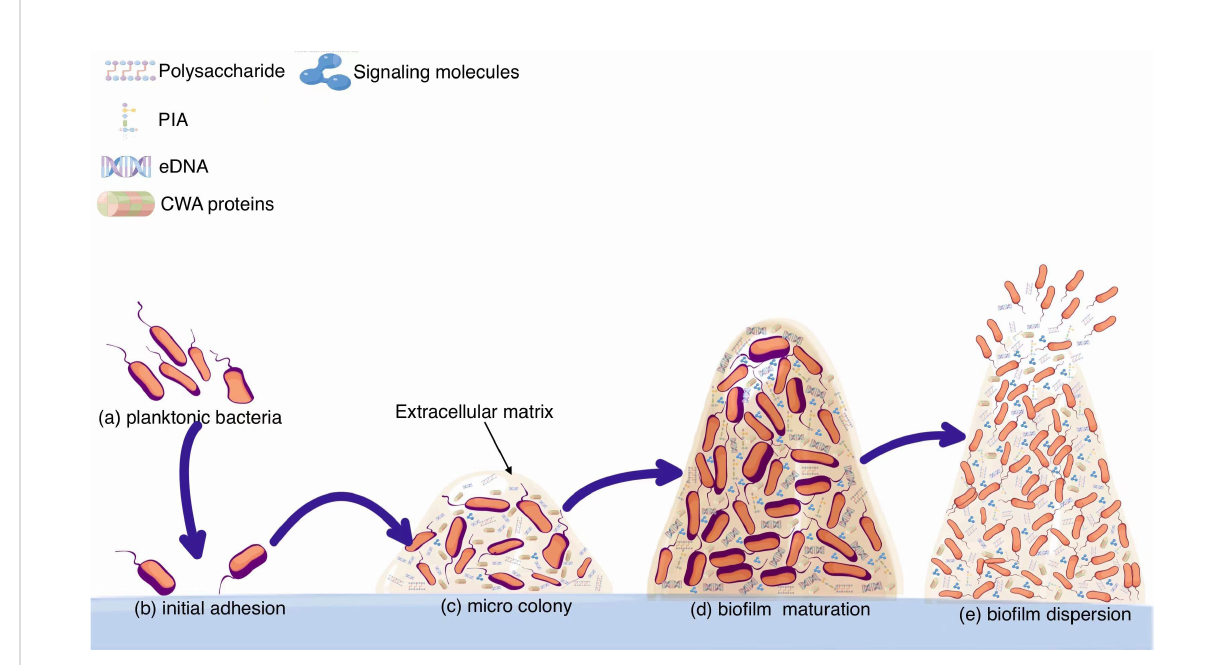
FIGURE 1 From planktonic bacteria to mature bio fi lms. (A) Planktonic bacteria invade the wound and swim randomly. (B) Planktonic bacteria adhere to the implant surface, which is a reversible process. From forming microcolonies (C) to developing into mature bio fi lms (D) . (E) Bio fi lm breaks down and bacteria spread